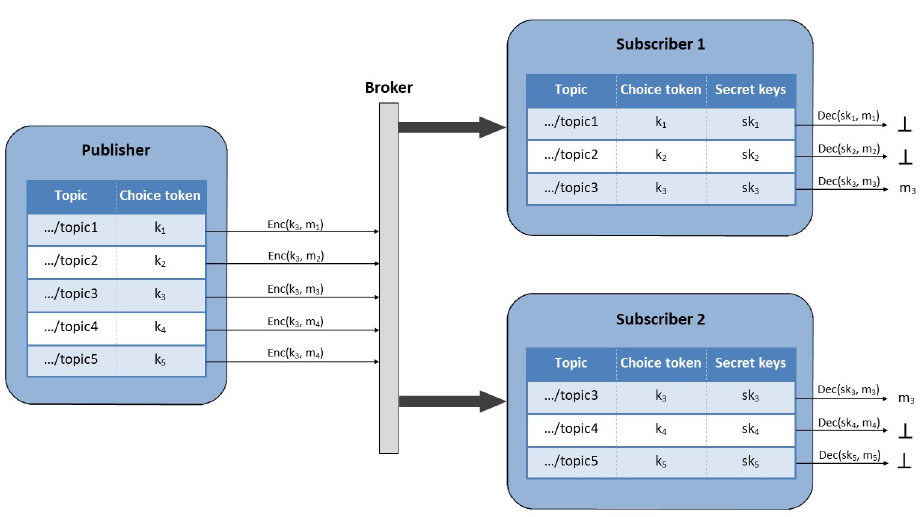
Figure 4. Model_1.0— .../topic3 is